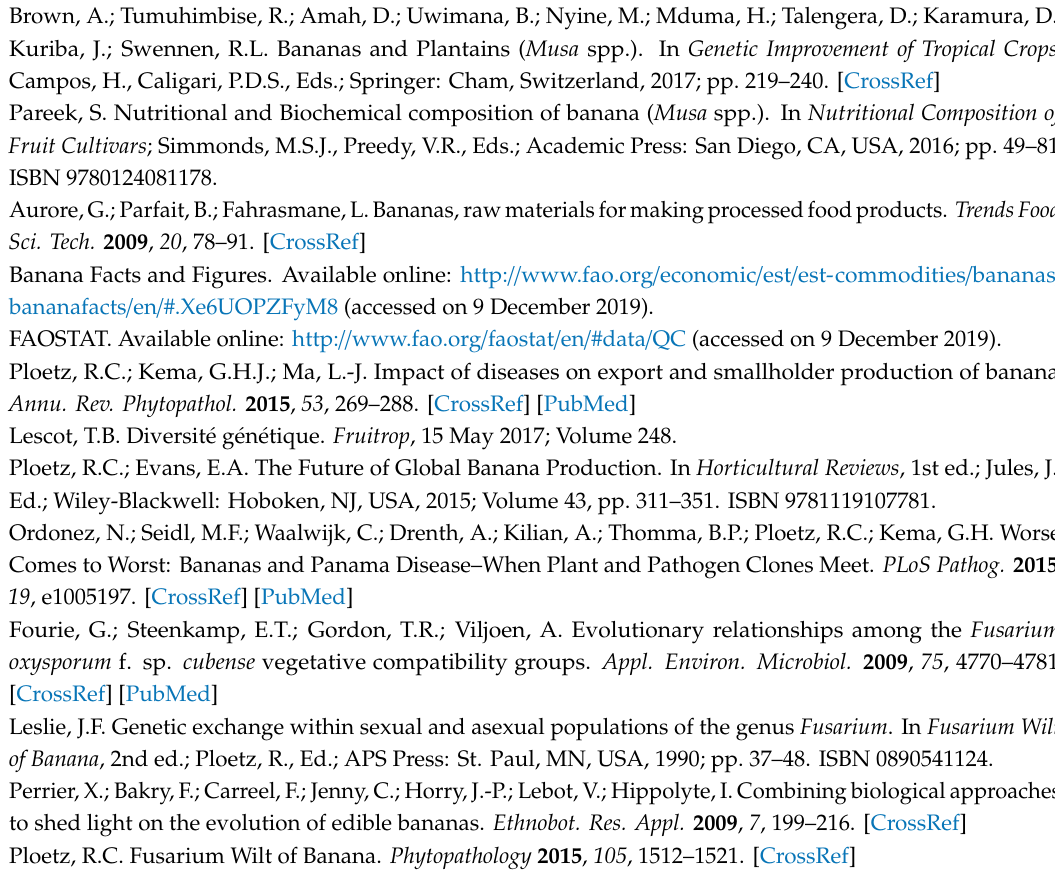
Figure S1: Best ML tree inferred from TEF sequences of Foc population of Ecuador and other F. oxysporum isolates associated to banana; Figure S2: Polymerase chain reaction (PCR) analysis showing the presence of MAT1-2 idiomorph on Foc population of Ecuador; Table S1: List of Fusarium oxysporum isolates associated with banana used in this study; Table S2: GenBank accession numbers of Foc and other F. oxysporum isolates used for phylogenetic